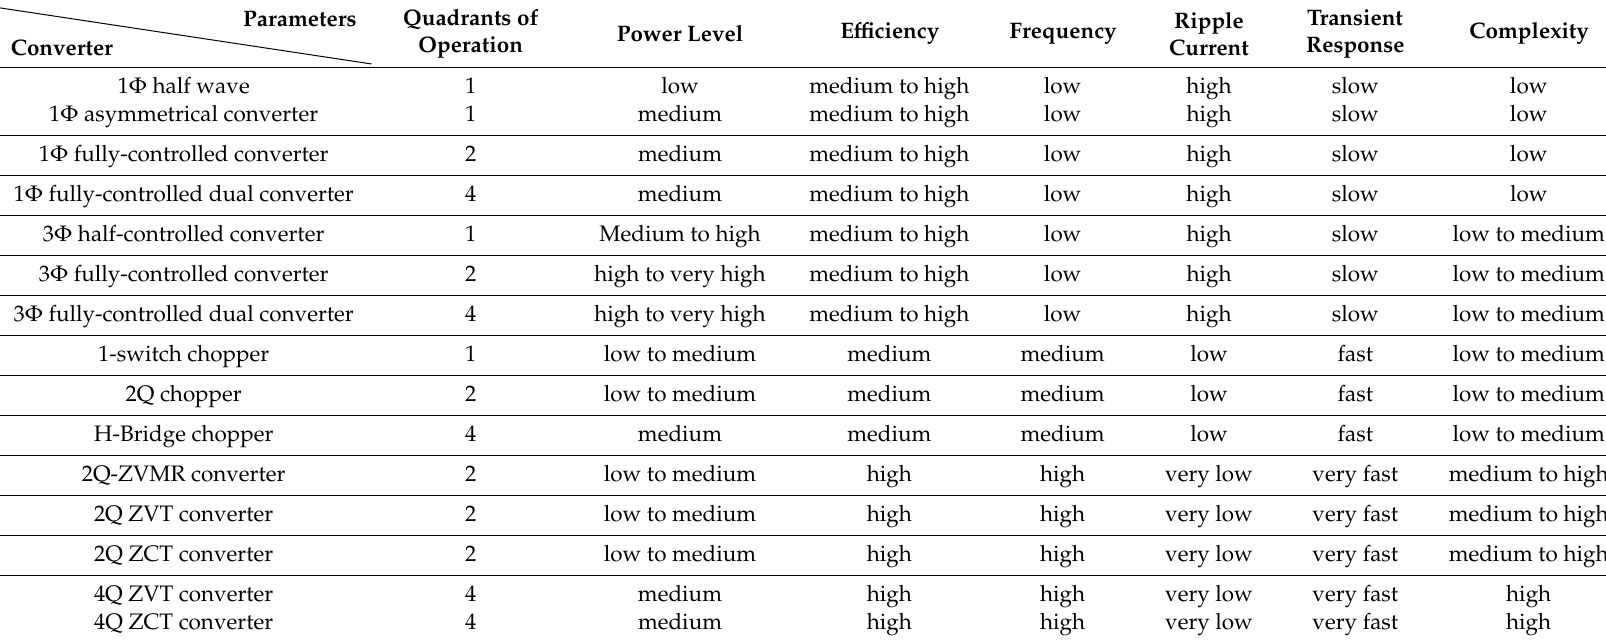
Table 4. Comparative assessment of converters for brushed DC motor